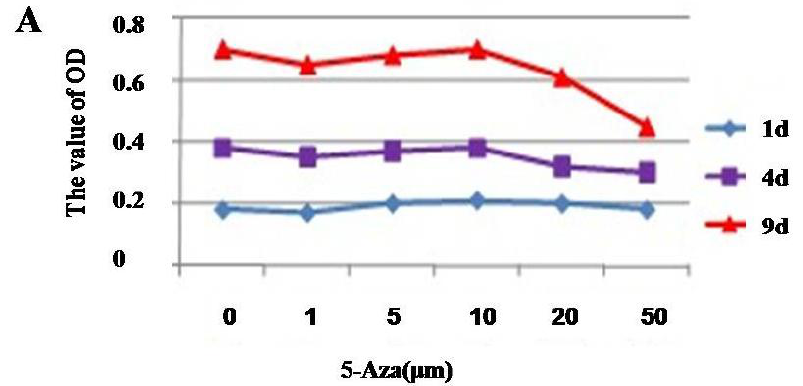
Figure 4. The optimal concentration of 5-Aza treatment induced cardiomyocyte-like